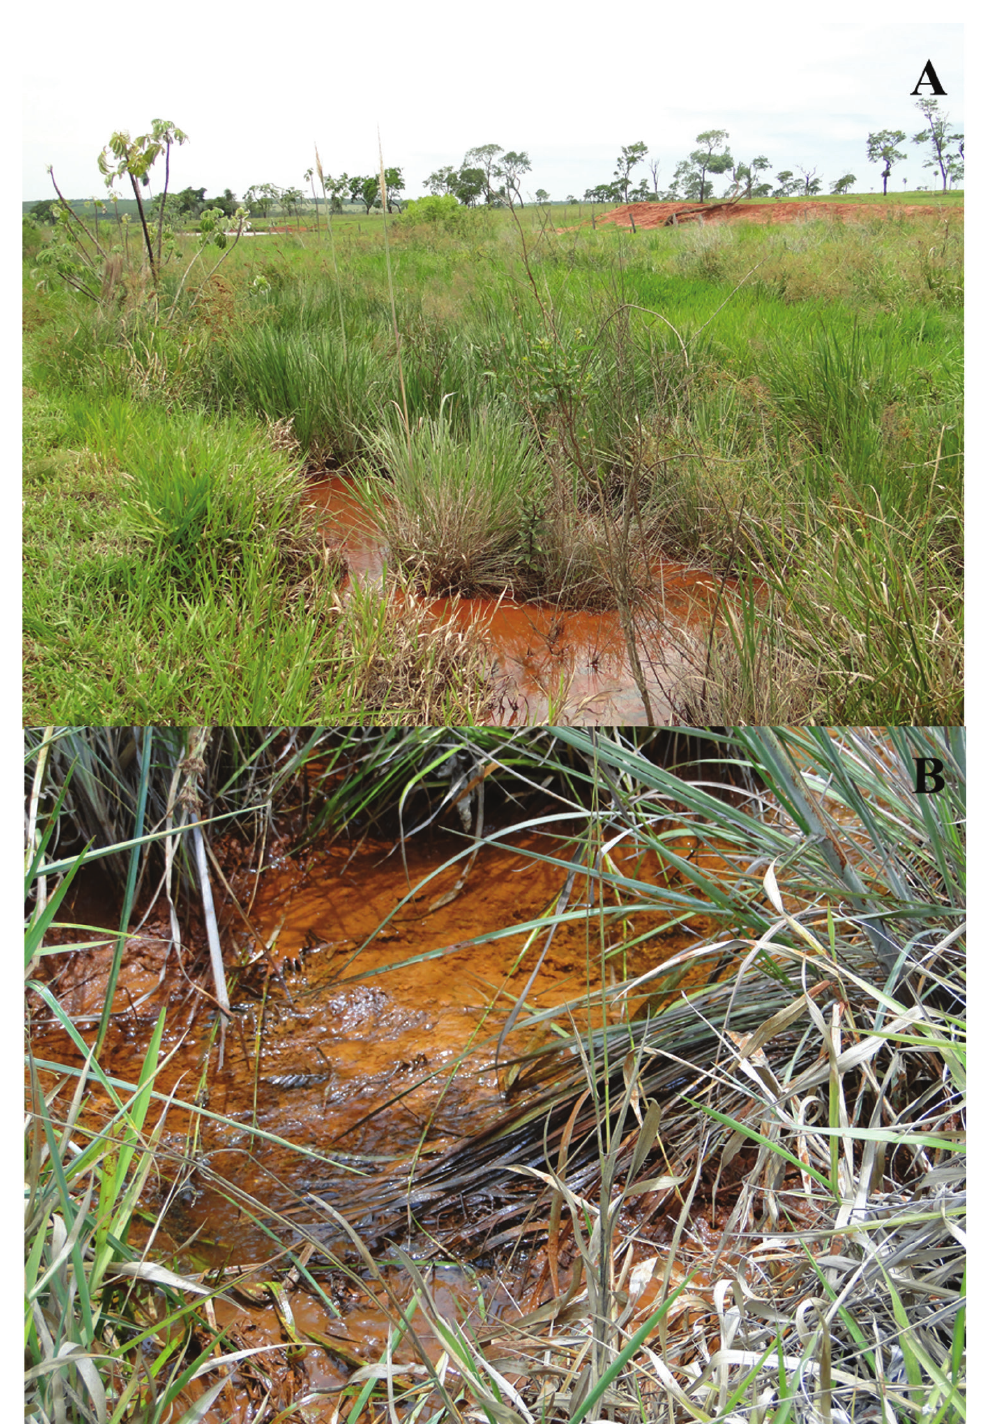
Figure 10. Water source of a first-order stream on the left bank of the Rio Amambaí, marginally situated along the BR 487 highway, type locality of M. amambaiensis